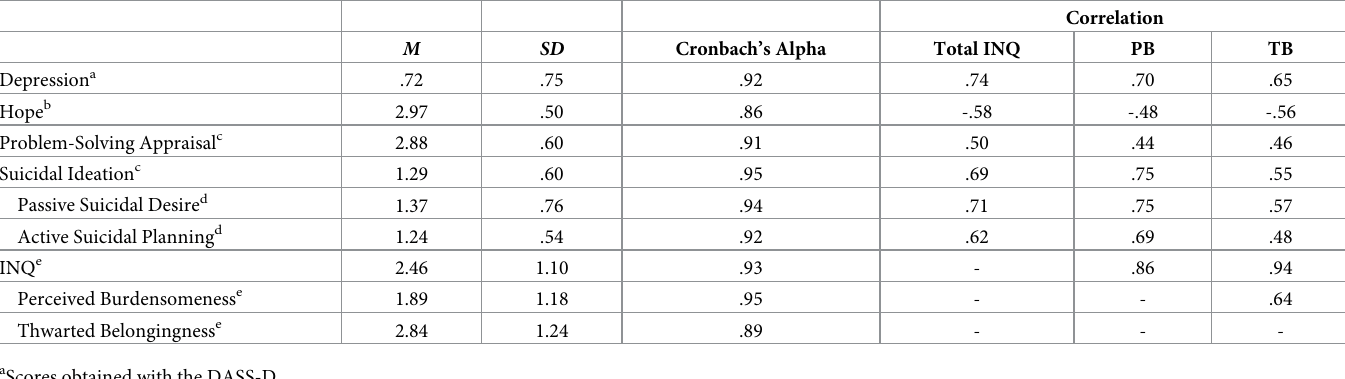
Table 2. Descriptives, internal reliability and bivarate correlations between DASS-D, hope, PSI, SIS, and INQ